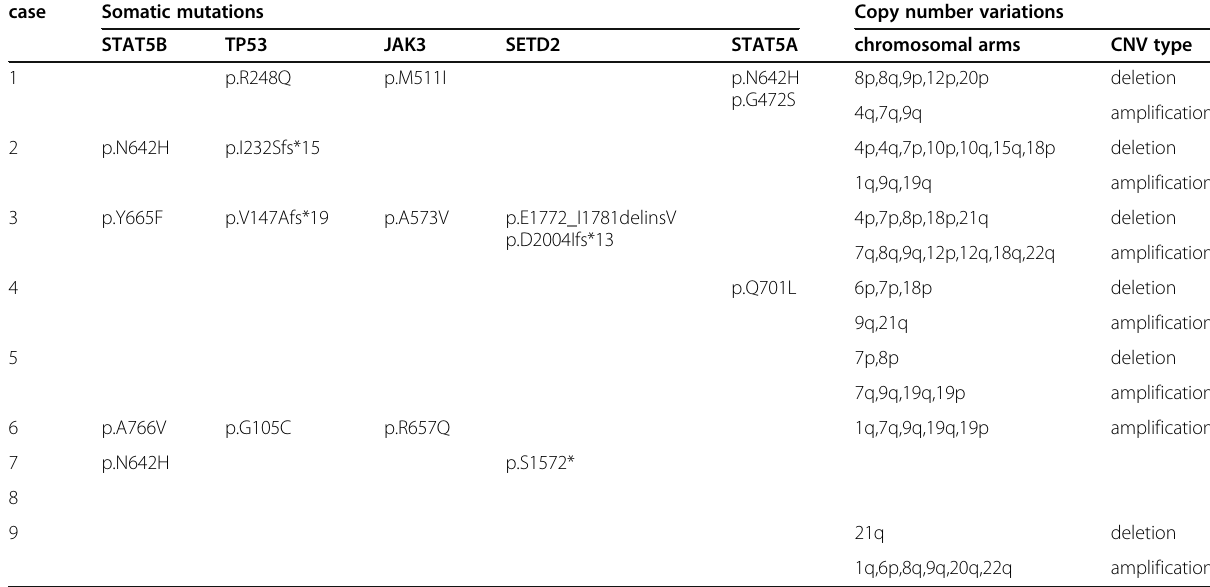
Table 2 The main genetic findings of 9 MEITL